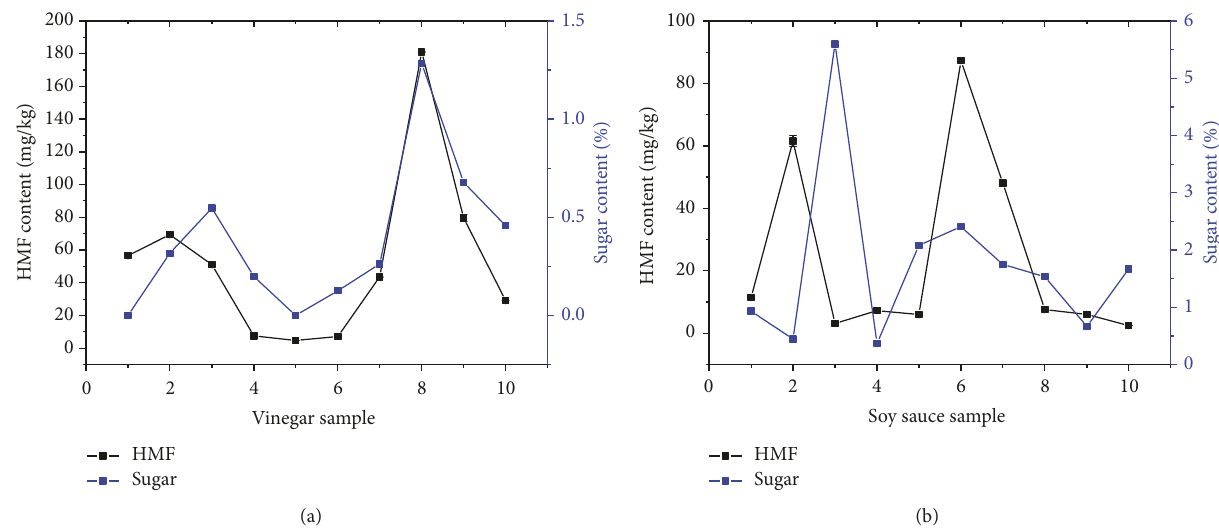
1.283% (sample A8), where 0.990% of glucose and 0.293% of fructose were included. And the second highest sugar content was 0.667% (sample A9), where only glucose was